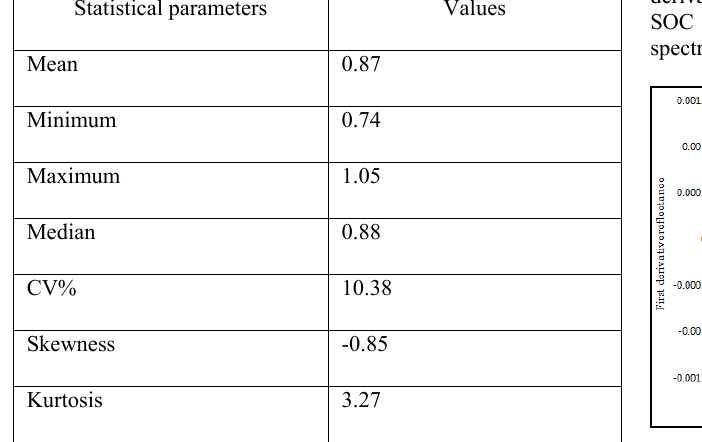
Figure 2. First derivative reflectance spectra of soil